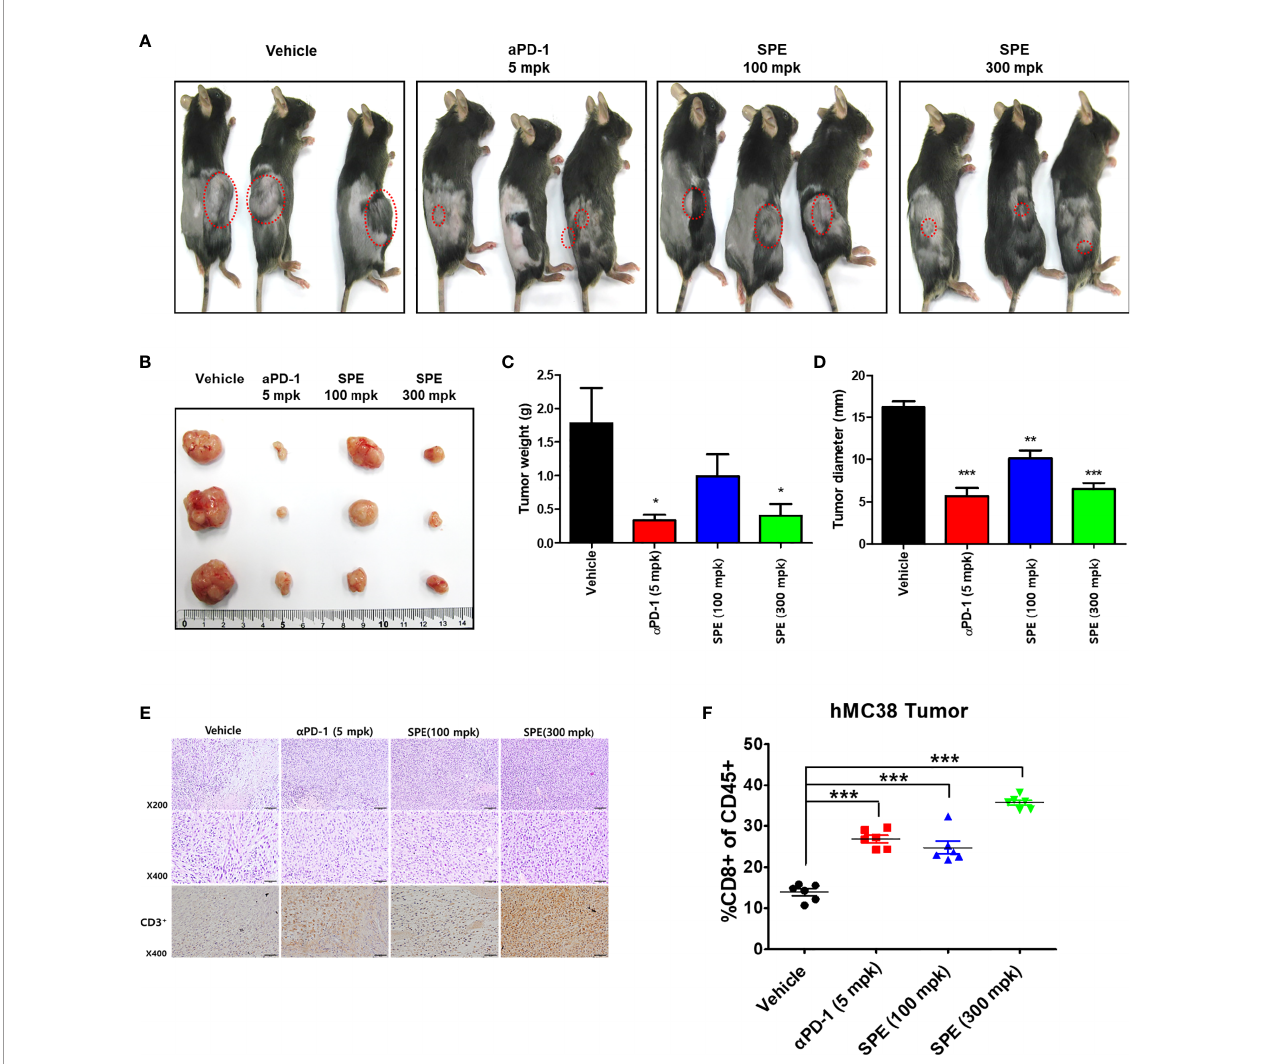
FIGURE 7 | Anti-tumor ef fi cacy of SPE on hPD-L1 MC38 tumor growth in hPD-1 knock-in mice. (A) Representative images show the tumor development at 16 days after treatment. Mice were inoculated s.c. with hPD-L1 MC38 cells and were administrated with aPD-1 (5 mg/kg, i.p.) or SPE (100, 300 mg/kg, i.g.) (n=3). Tumor mice received an equivalent volume of vehicle (200 µL). (B) Image of subcutaneous tumor mass on day 16 (scale bars, 1 cm) (n=3). (C) Mean tumor weight (n=3). (D) Mean tumor diameter (n=3). (E) Immunohistochemistry staining of CD3+ in humanized PD-1 mouse model of tumor. (F) FACS analysis of tumor CD8+ T- cell populations from human PD-L1 knock in MC 38 tumor-bearing model of humanized PD-1 mice. Percentages of polyclonal CD8+ T-cells of CD45+ cells in tumor. Bar graph (mean ± standard error of the mean) statistics were determined with one-way ANOVA with Tukey ’ s post-hoc test; ***P < 0.001, **P < 0.01, *P < 0.05, compared with the vehicle